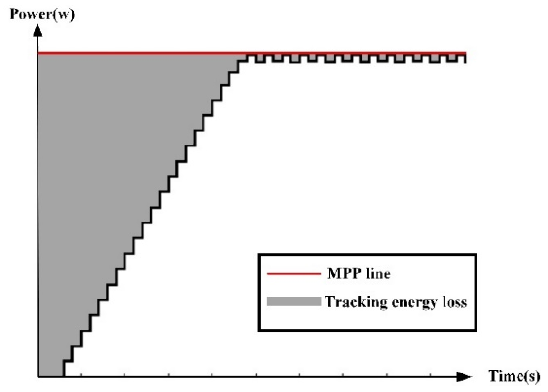
Figure 2. Illustration of tracking energy loss. MPP: Maximum Power Point.